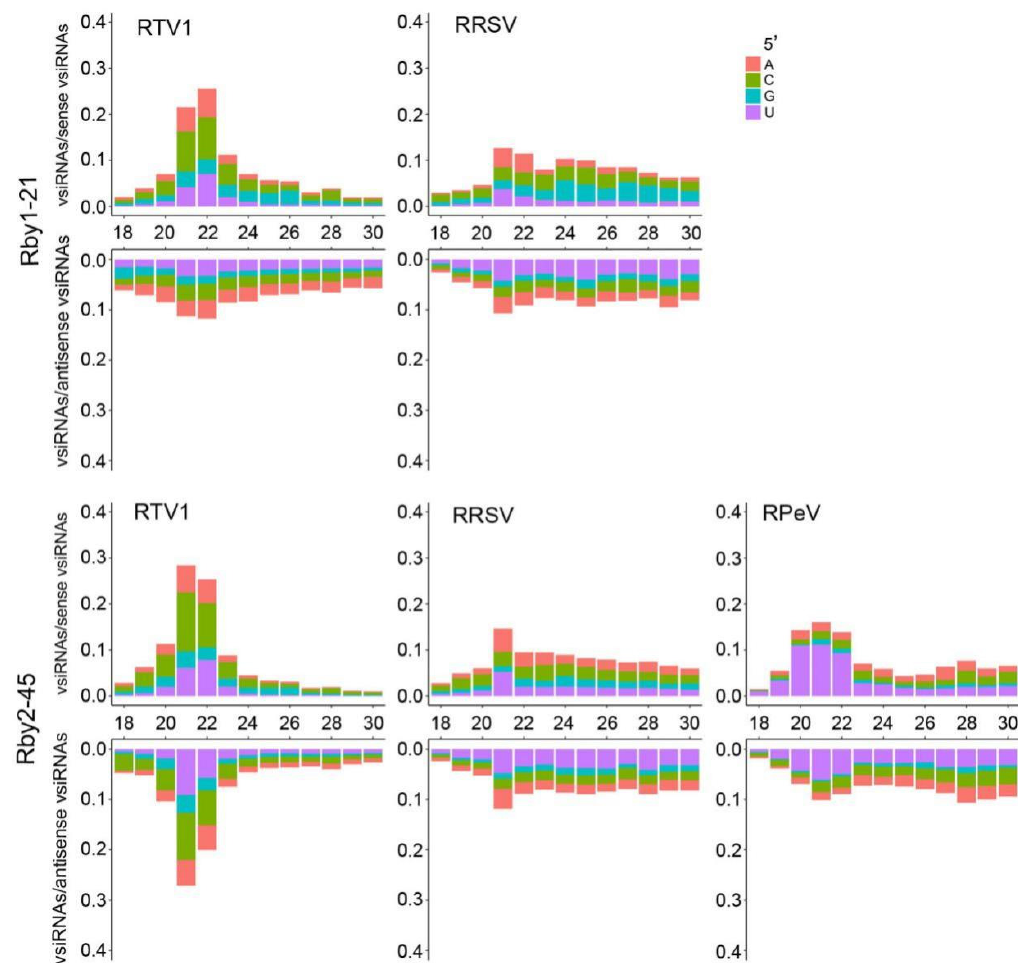
Figure 4. Small RNA analysis of RTV1, RRSV, and RpeV in Rby1-21 and Rby2-45. Size distribution (18 to 30 nt) and strand directionality of virus-derived small RNA arising from RTV1 and RRSV from Rby1-21 as well as RTV1, RRSV and RpeV from Rby2-45. Relative abundance of differing-size sense vsiRNAs ( top ) is shown as the proportion of sense vsiRNAs. Relative abundance of differing-size antisense vsiRNAs ( bottom ) is shown as the proportion of antisense vsiRNAs. Bars plotted above the x axis represent vsiRNAs mapping to the positive strand. Bars plotted below the x axis represent vsiRNAs mapping to the negative strand. Bars are colored according to the proportions of vsiRNAs starting with A, C, G, and U.